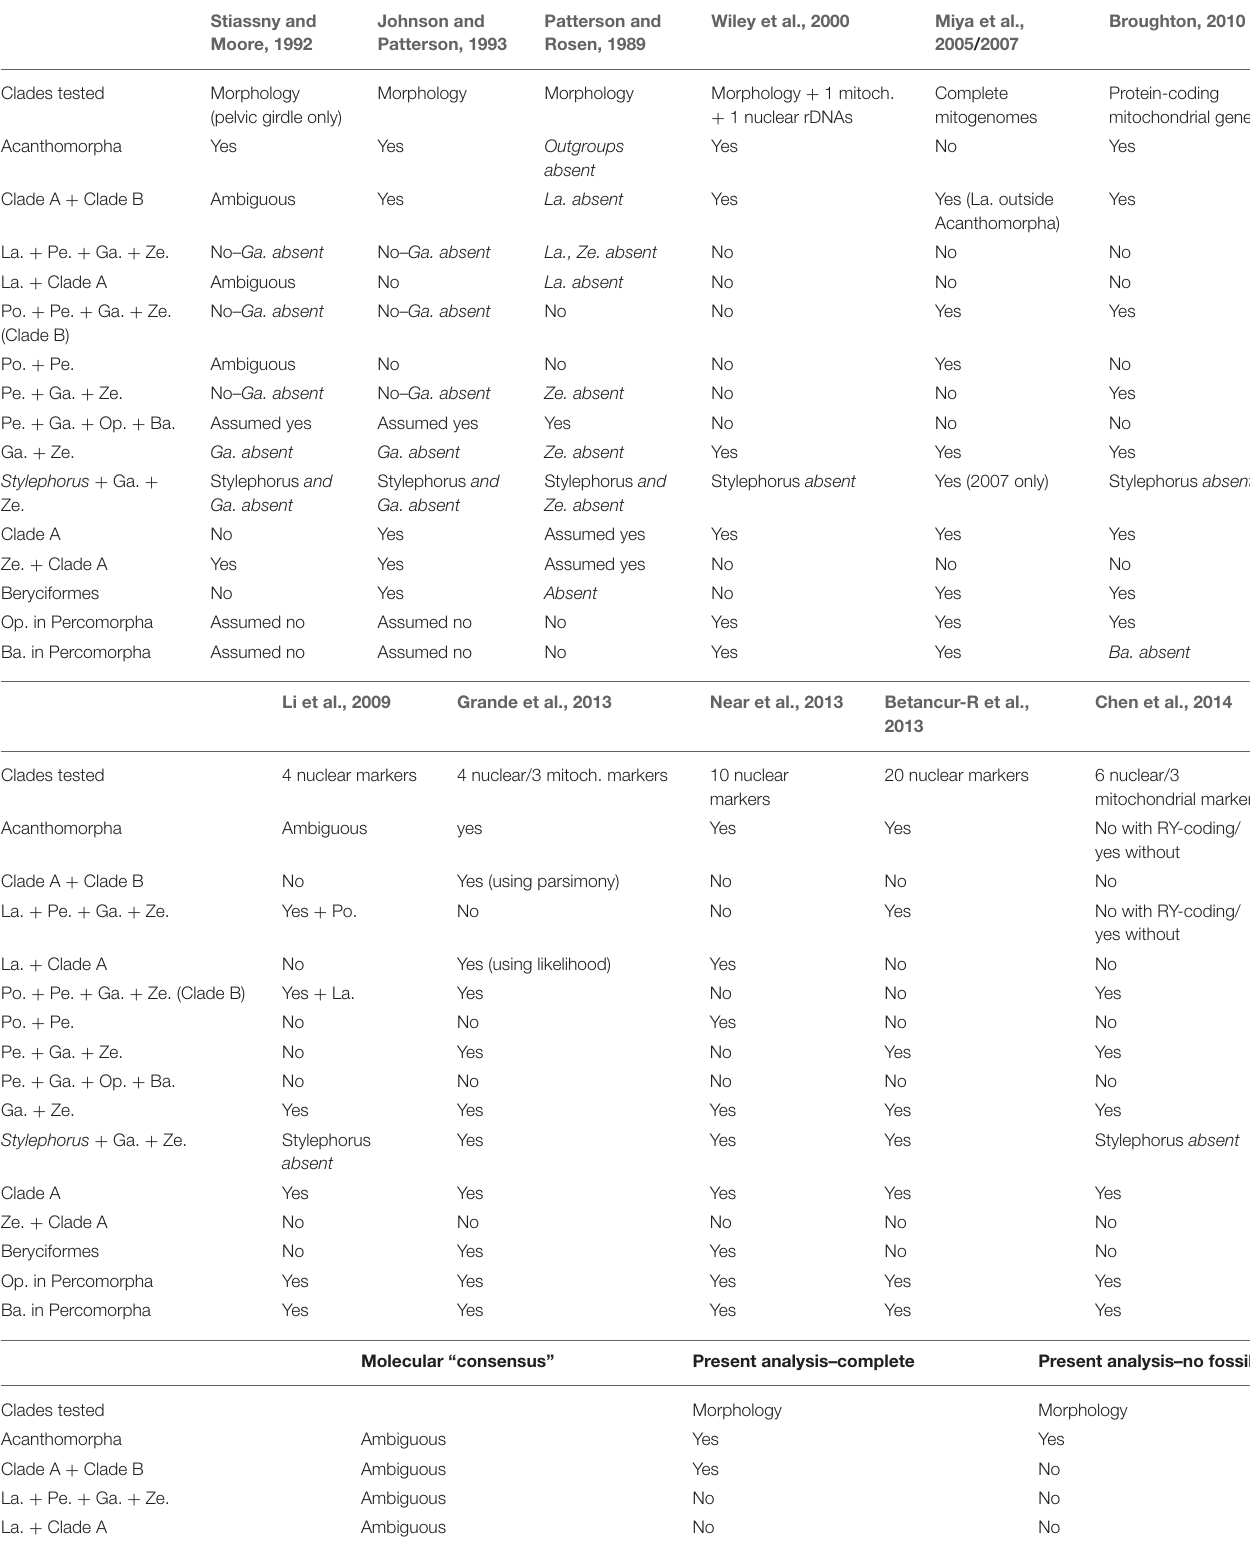
TABLE 1 | Summary of the main studies presented in this article, and associated phylogenetic